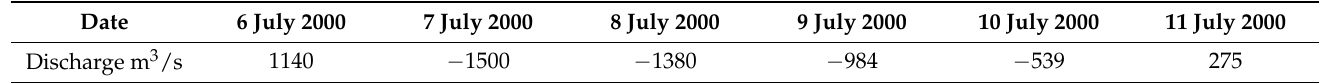
Table 1. The observation discharge data of Hukou hydrological station from 7 to 10 July 2000.